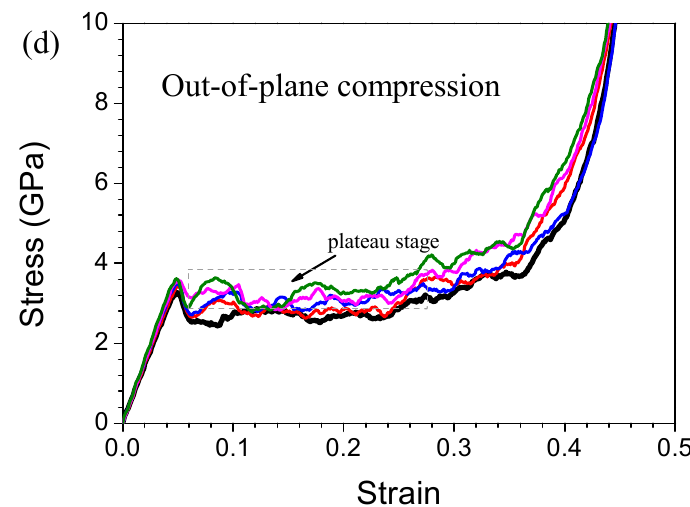
Figure 7. Stress-strain curves of CNHONNs along different deformation direction: ( a ) In-plane tension, ( b ) In-plane compression, ( c ) Out-of-plane tension and ( d ) Out-of-plane compression.